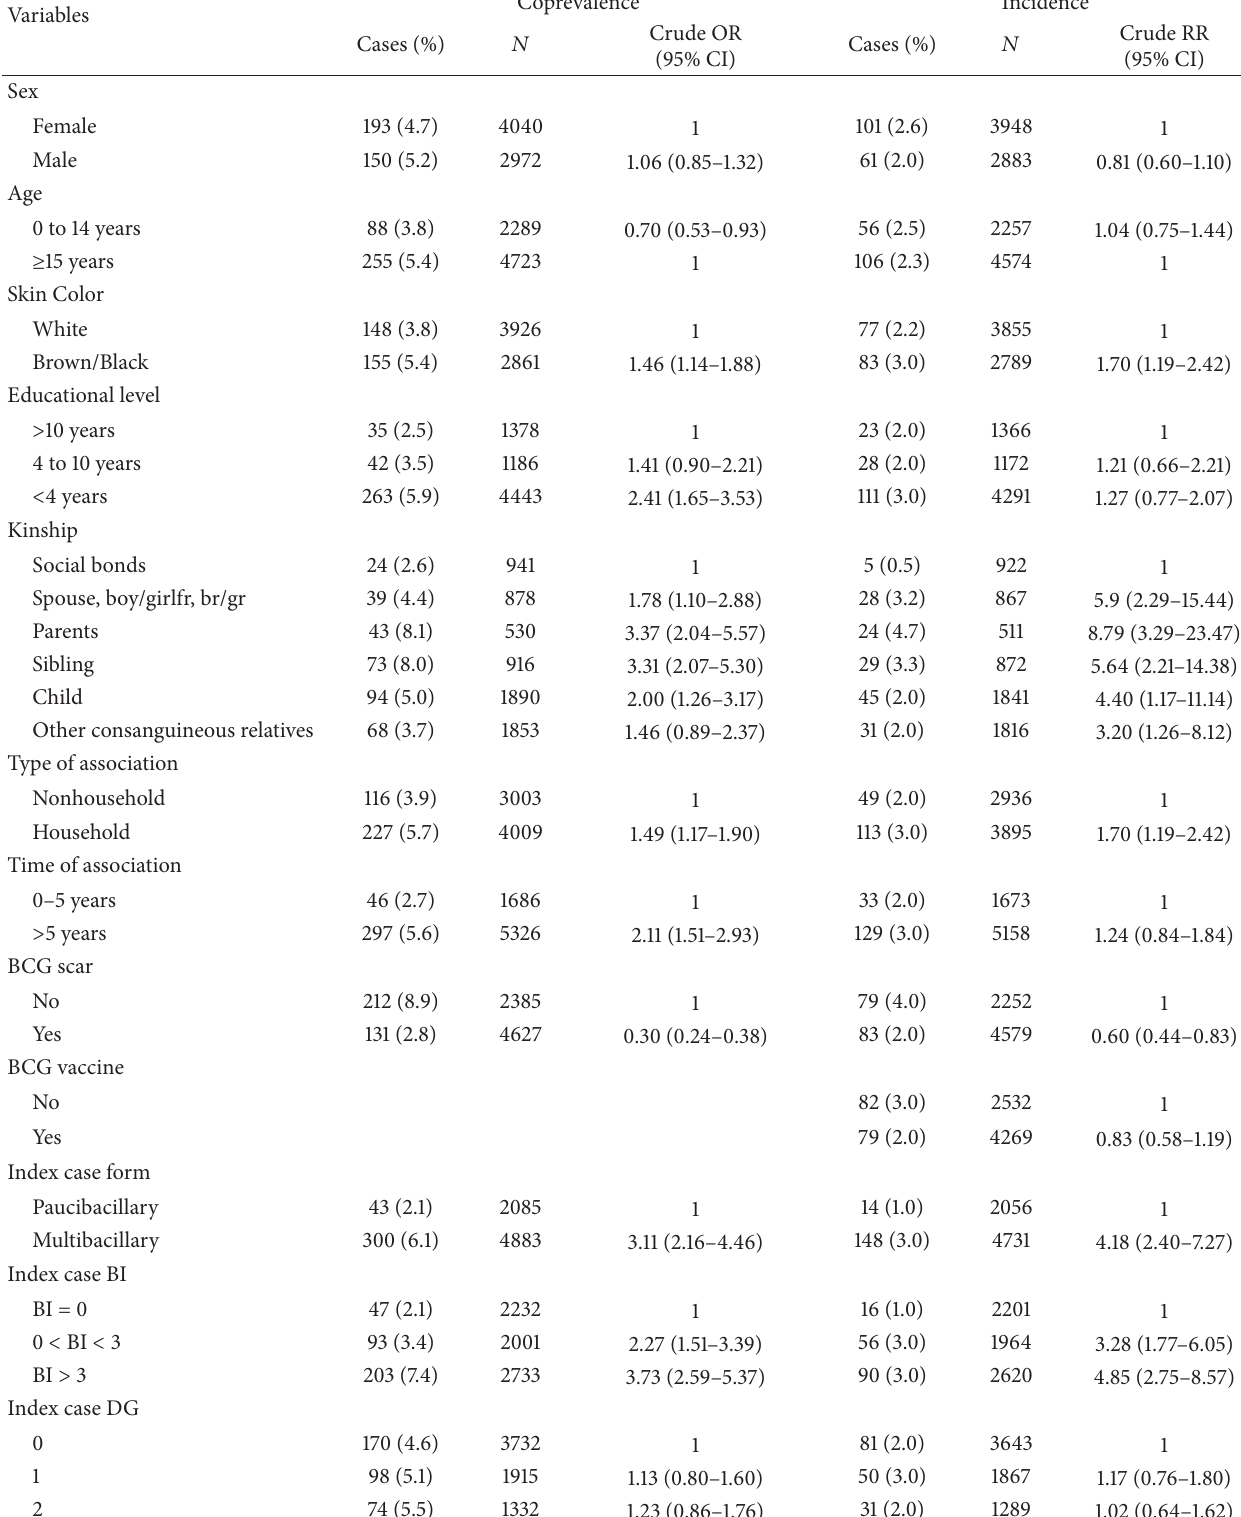
Table 1: Frequency distribution and bivariate analysis of the prevalence and incidence cases of a cohort of contacts at the Souza Ara´ujo Outpatient Clinic, Rio de Janeiro, RJ,